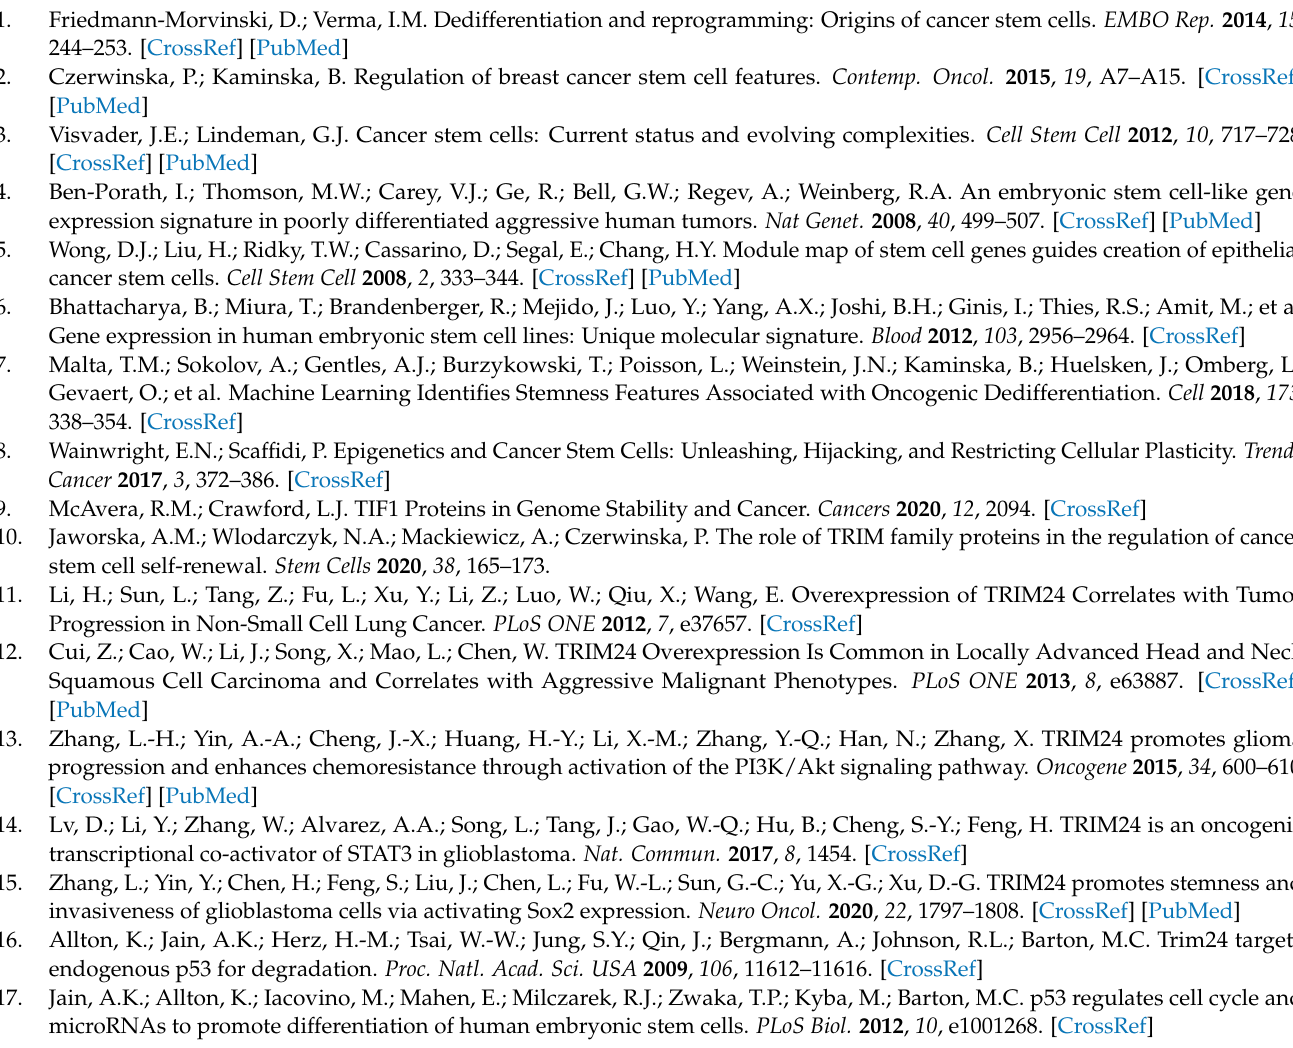
Table S3: Multivariate logistic regression analysis for predictive markers of the stemness HIGH tumor